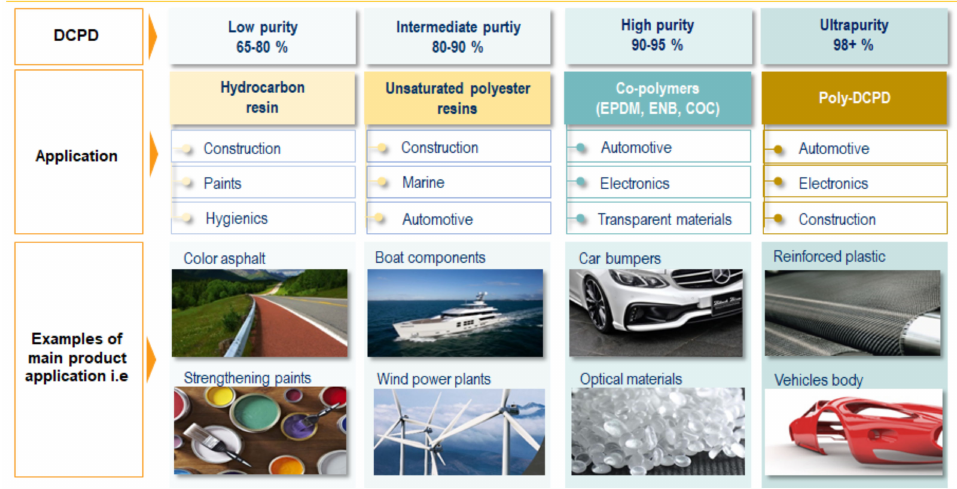
Figure 1. DCPD commercial grades, top consuming sectors and